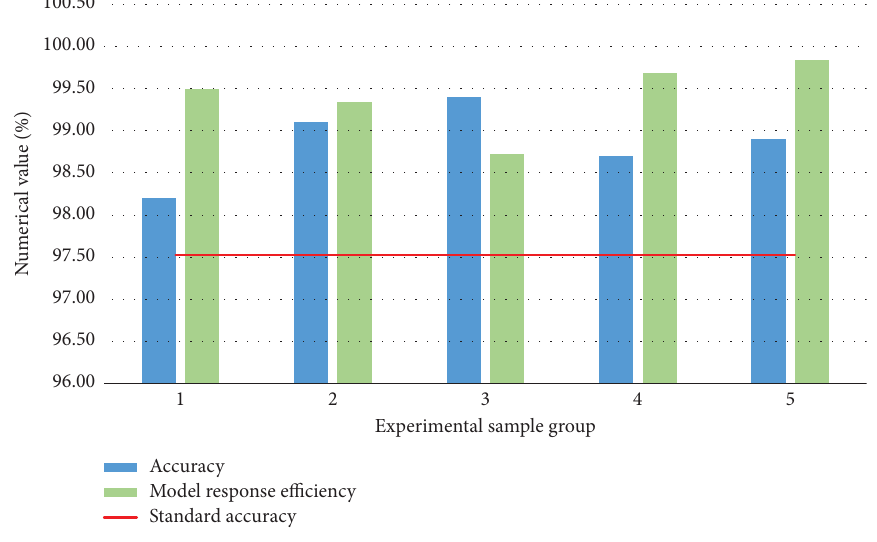
Experimental sample group